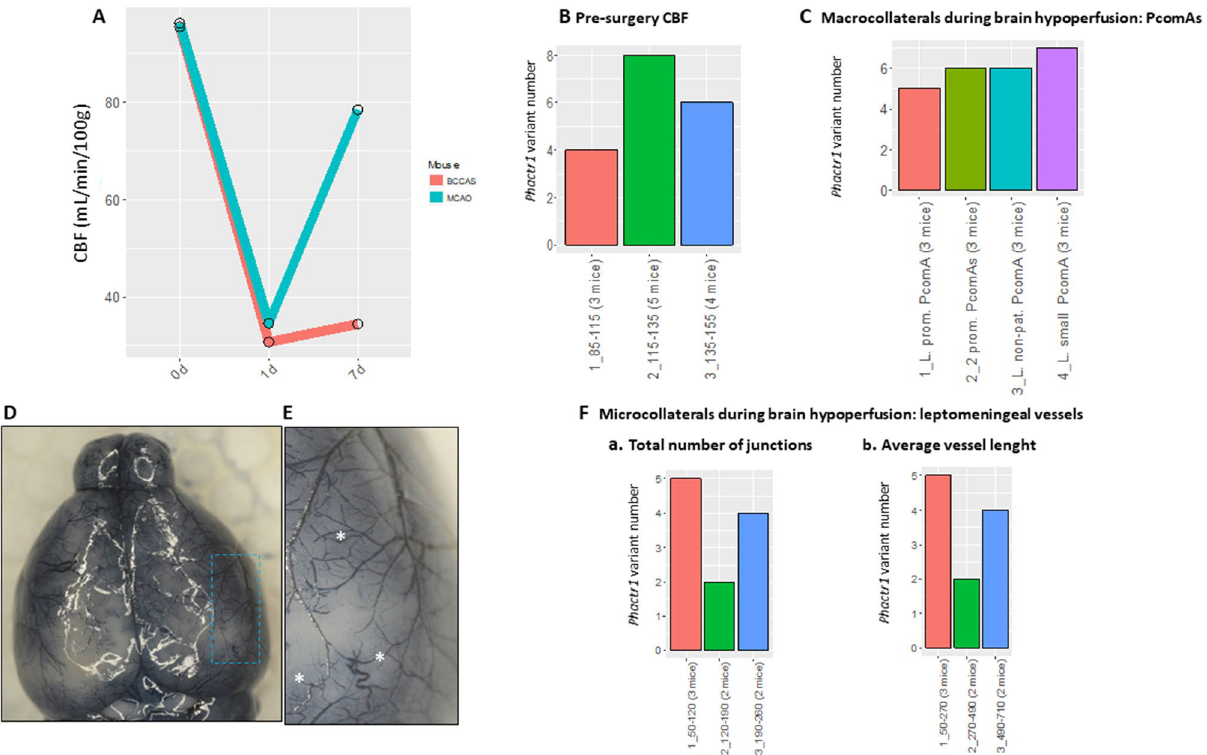
Figure 5. Phactr1 pooled variant analysis in the BCCAS and MCAO mouse cohort. ( A , B ) Analysis of the cerebral blood flow (CBF) pre-surgery. ( A ) CBF pre-surgery and its severe drop (≈ 60–70% of the CBF pre- surgery) 1 day post-surgery and progressive recovery 7 day post-surgery, in BCCAS and MCAO mice. The graph was generated pooling CBF values for left striatum for 6 BCCAS and MCAO mice. ( B ) CBF values pre-surgery obtained pooling the CBF values measured in right and left cortex and striatum in MCAO (nine mice) and BCCAS (three mice). CBF values are expressed in ml/min/100 g. ( C ) Analysis of macrocollaterals: PcomA size. ( D – F ) Analysis of the leptomeningeal microcollaterals. ( D ) BCCAS mouse 7 days post-surgery, perfused with Evans Blue, axial view. ( E ) Anastomoses between leptomeningeal microcollaterals (asterisk). ( F ) Leptomeningeal vessels in the MCAO model (left hypoperfused hemisphere): a. average vessel length and b. total number of junctions. Some of these data have been already published 27